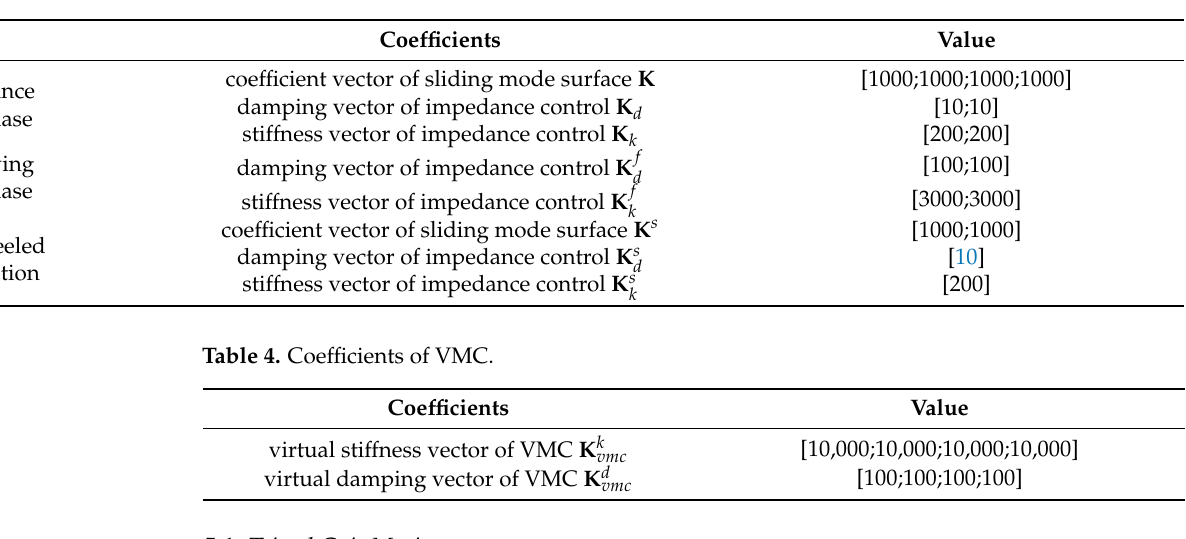
Table 3. Coefficients of TeCVP.